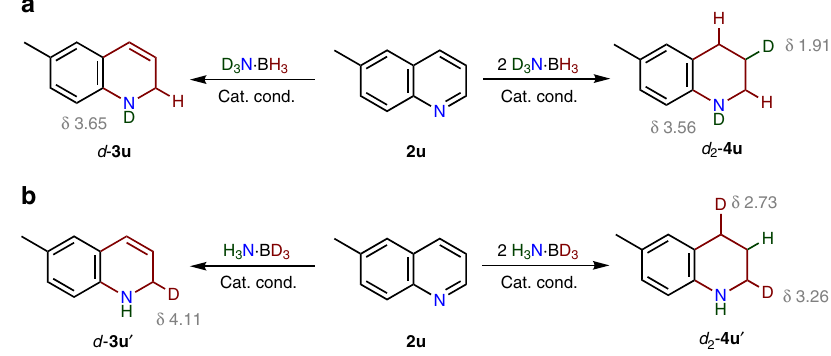
Fig. 5 Deuterium labeling experiments. a Reactions of 2u with D 3 N·BH 3 . b Reactions of 2u with H 3 N·BD 3 fi rst-order dependence on the dihydrogen source at this stage (Supplementary Fig. 7). These results indicate that all the three components are involved in the turnover-limiting formation of 3u . The overall rate law of this dihydrogenated reaction is thus expressed by rate = k obs [ 1 ][ 2u ][H 3 N ∙ BH 3 ]. Deuterium kinetic isotope effects (DKIE) were further probed for the dihydrogenation reaction (Supplementary Fig. 8).